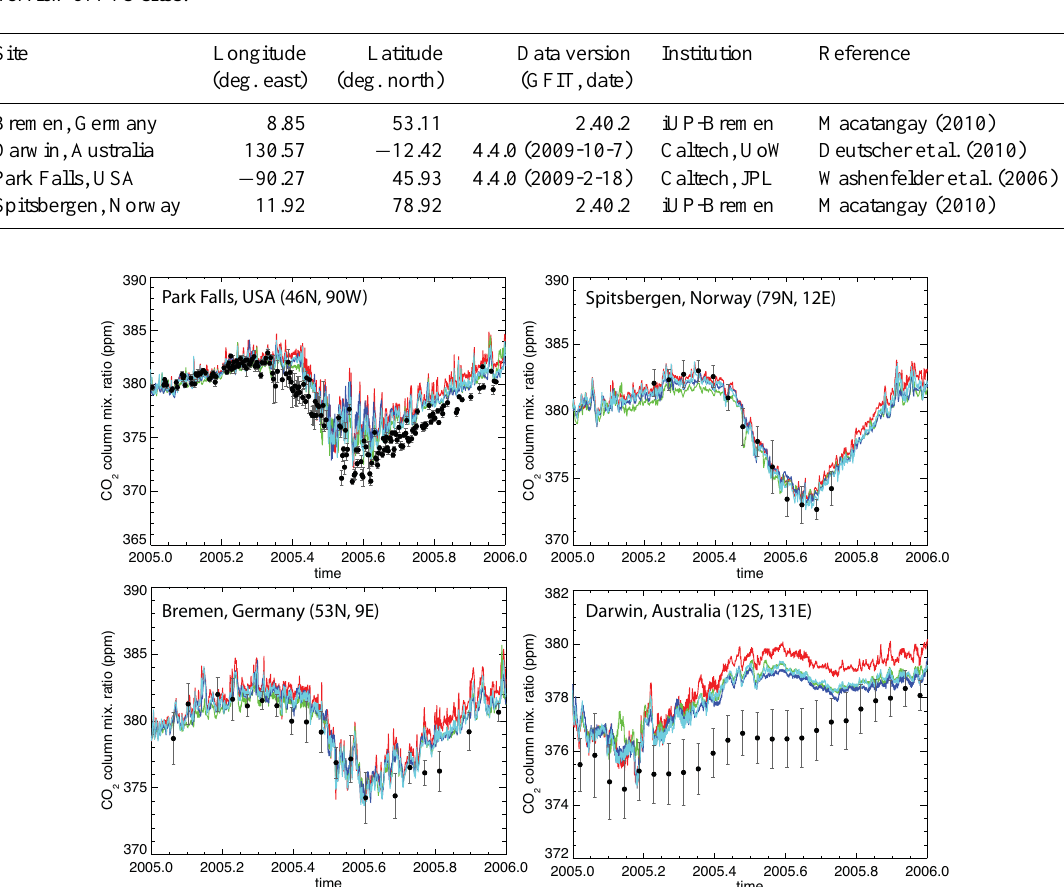
Fig. 1. Comparison between model-simulated and FTS measured x CO 2 . Red, IFS; Green, LMDZ; Blue, TM3; Cyan, TM5; Black, mea- surements. For Park Falls, the measurements represent daily averages, plotted with their 1 σ variability within the day. At the other sites the measurements represent half monthly averages reconstructed from the available years of data (see text). Here the 1 σ intervals represent the variability of the measurements within each half monthly